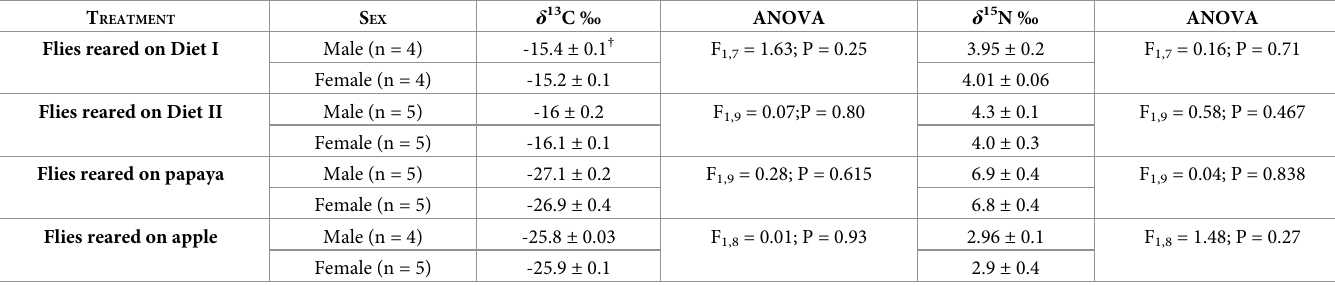
Table 3. Mean isotopic composition of males and females of Anastrepha fraterculus flies reared on different larval diets and fruits.